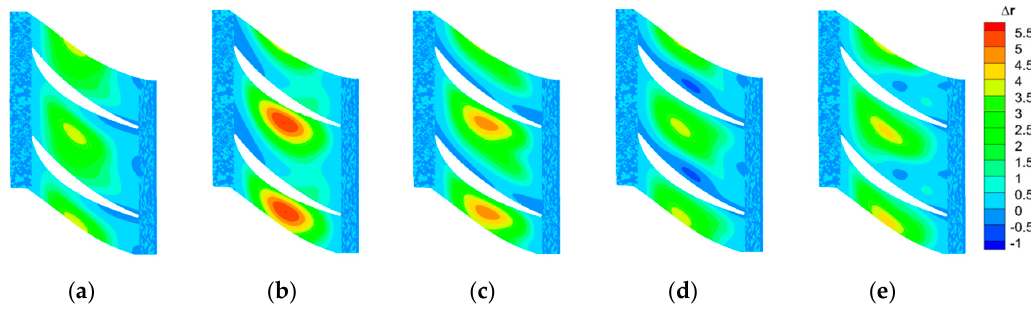
Figure 14. Geometries of the optimized results. ( a ) Objective function of 𝜛 (cid:3047) ; ( b ) objective function